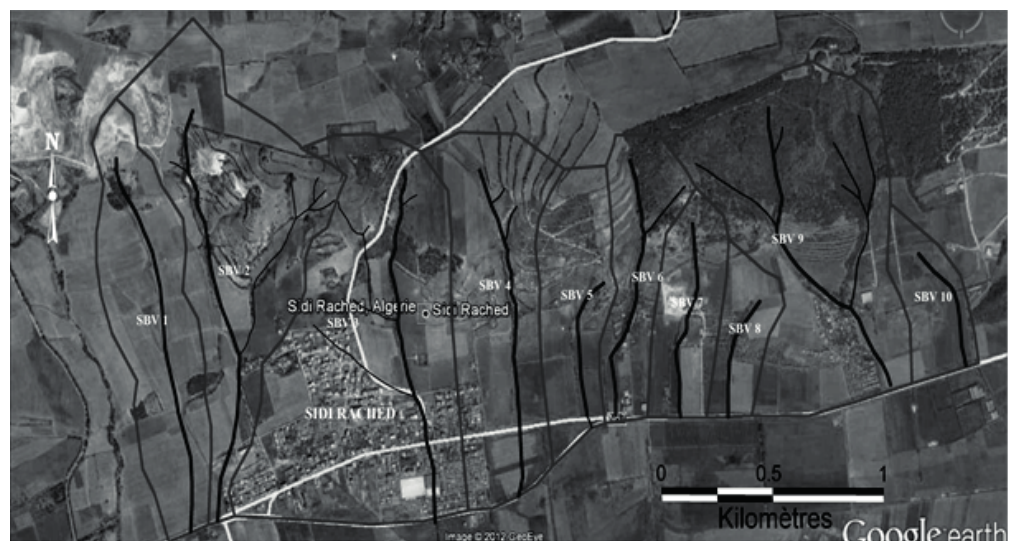
Fig.1 Urban and suburban catchments and rivers: untreated satellite image (Landsat, 2012, Algerie n-32–35).